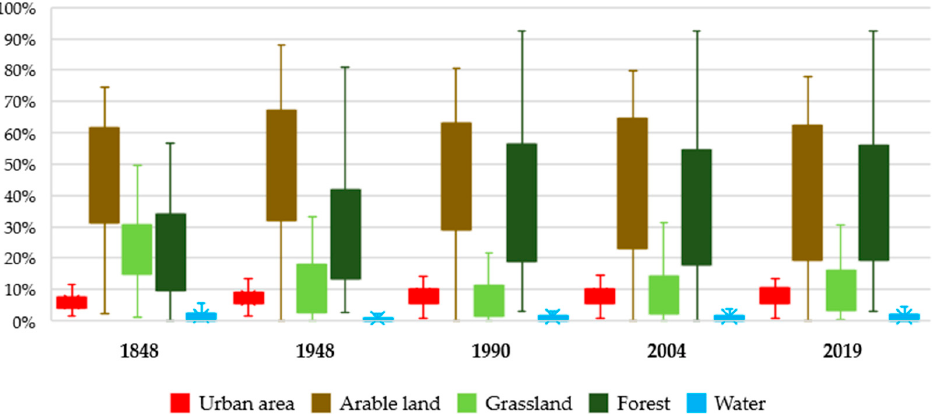
Figure 4. Average percentage values of land use categories representation in all checked cadastral territories for individual years based on analysis of actual land use.